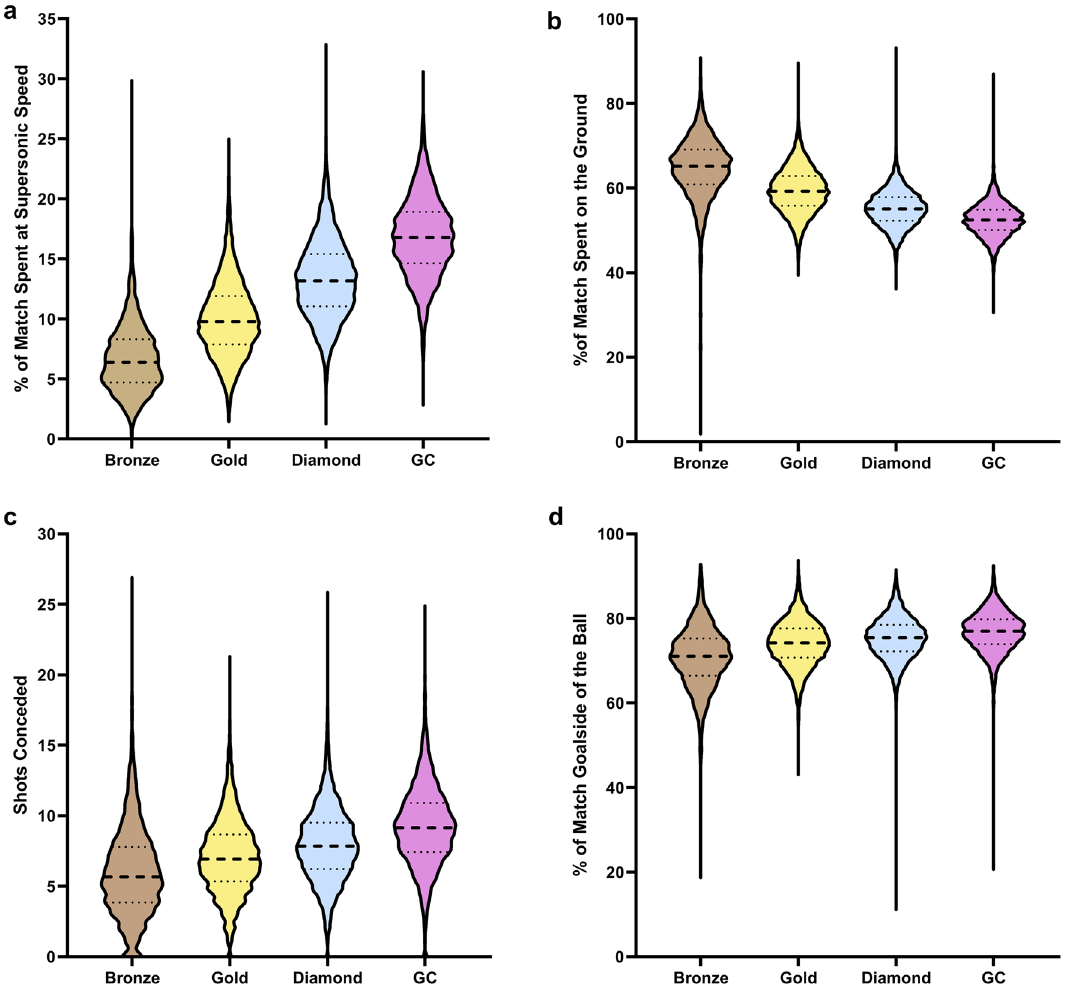
Figure 5. Violin plots displaying the means and distributions, within each rank, of the four most important features for predicting rank, ( a ) time spent at supersonic speed, ( b ) time spent on the ground, ( c ) shots conceded, ( d ) time spent goalside of the